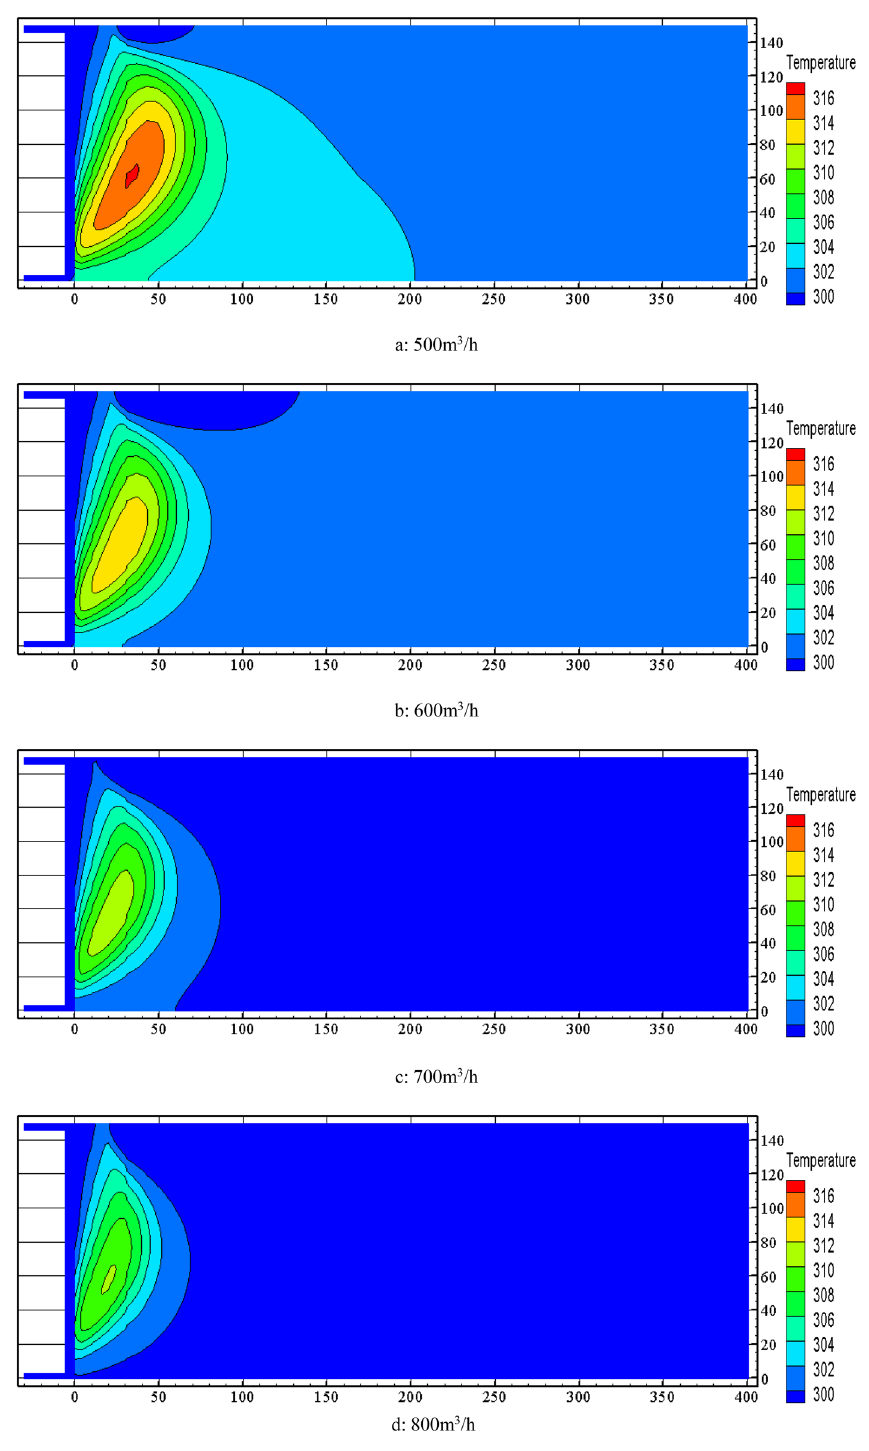
Figure 10. Effect of nitrogen injection volume on temperature field in